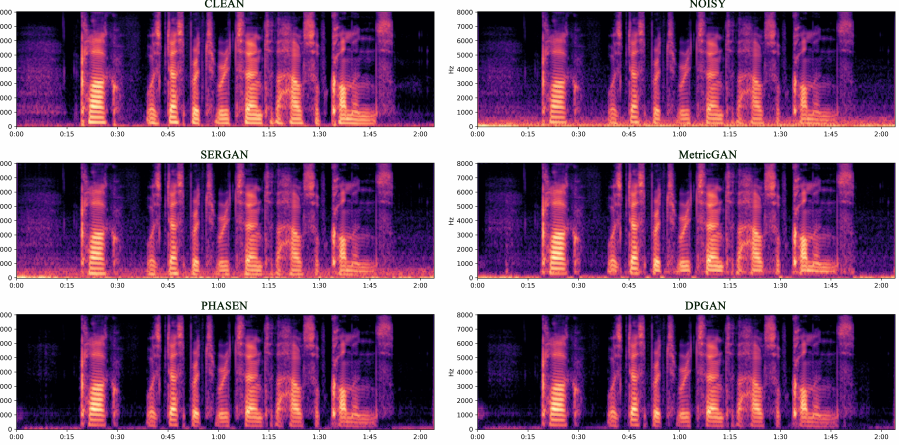
Figure 7. A comparative spectrogram of the enhancement effect of low frequency noise at higher signal-to-noise ratios is shown. The noise is shown in the plot as the cluttered highlighted blocks at the bottom.